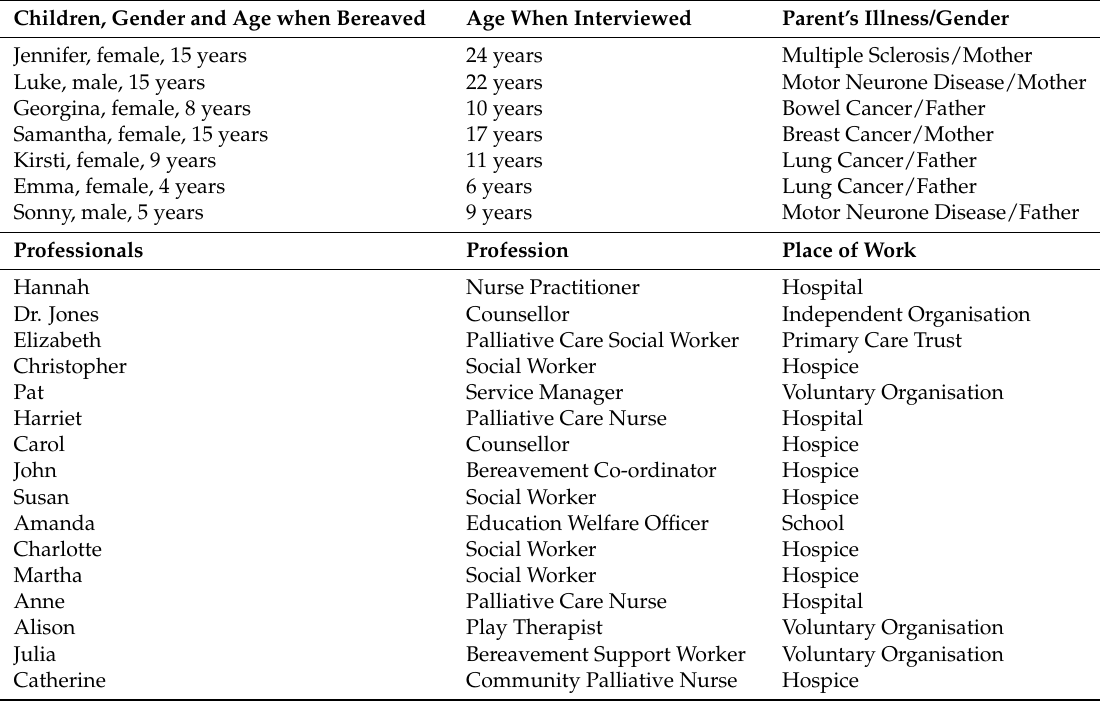
Table 1. Research Participants included in this study, divided into children and professions,